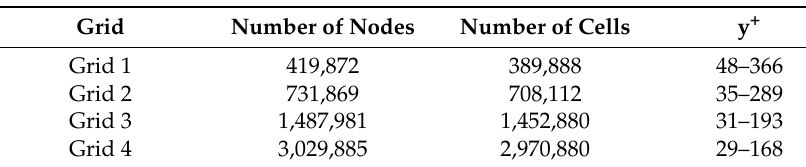
Table 4. Details of different meshes.